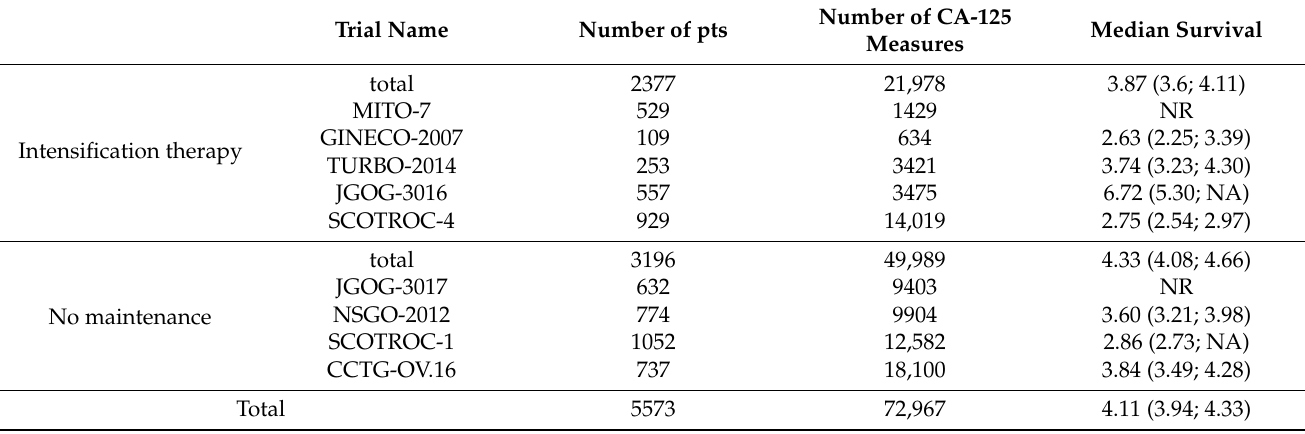
Table 1. Description of included studies.